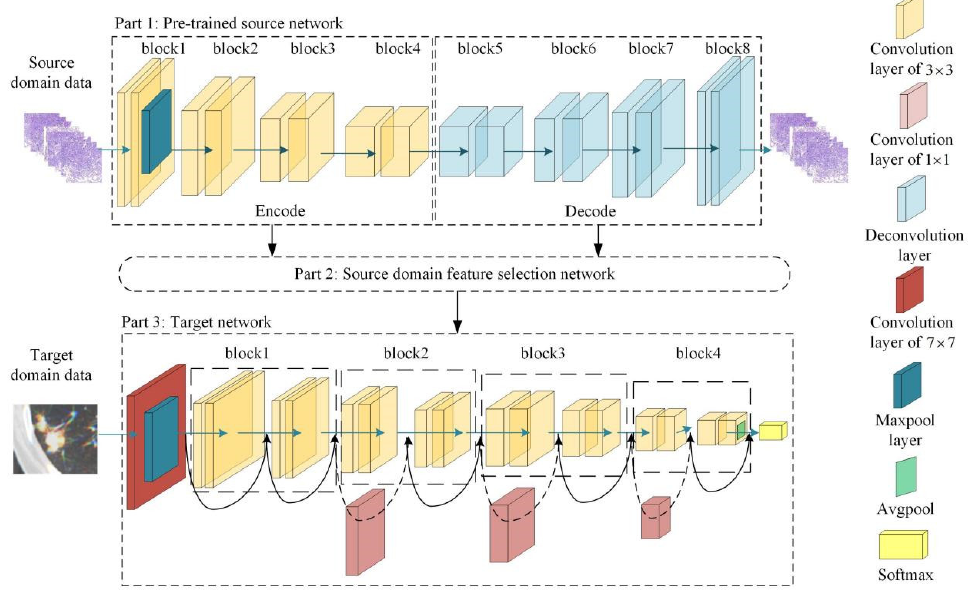
Figure 2. The structure of the adaptive cross-domain transfer learning model. The model has three parts: a pretrained source network; a target network; and a source domain feature selection network. When the target network was well trained, the convolution kernels of the target net- work were used as feature extractors to extract transfer learning features from the CT im- ages of SPSNs (Figure S3). Finally, 3904 transfer learning features were extracted for each patient.